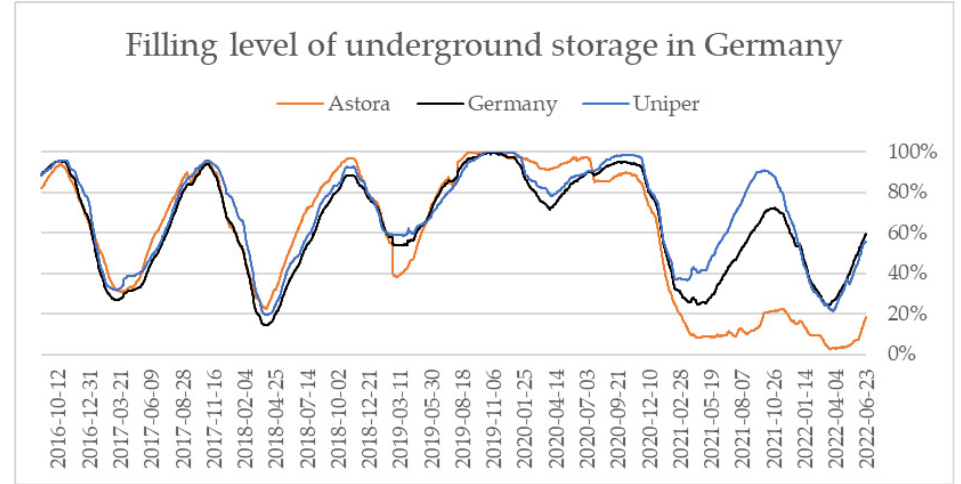
Figure 5. Filling level of Gazprom-owned Astora storage facilities, and those of Uniper, and total German storage capacity, 1 September 2016–23 June 2022. Source: [44]. German storage capacity, 1 September 2016–23 June 2022. Source: